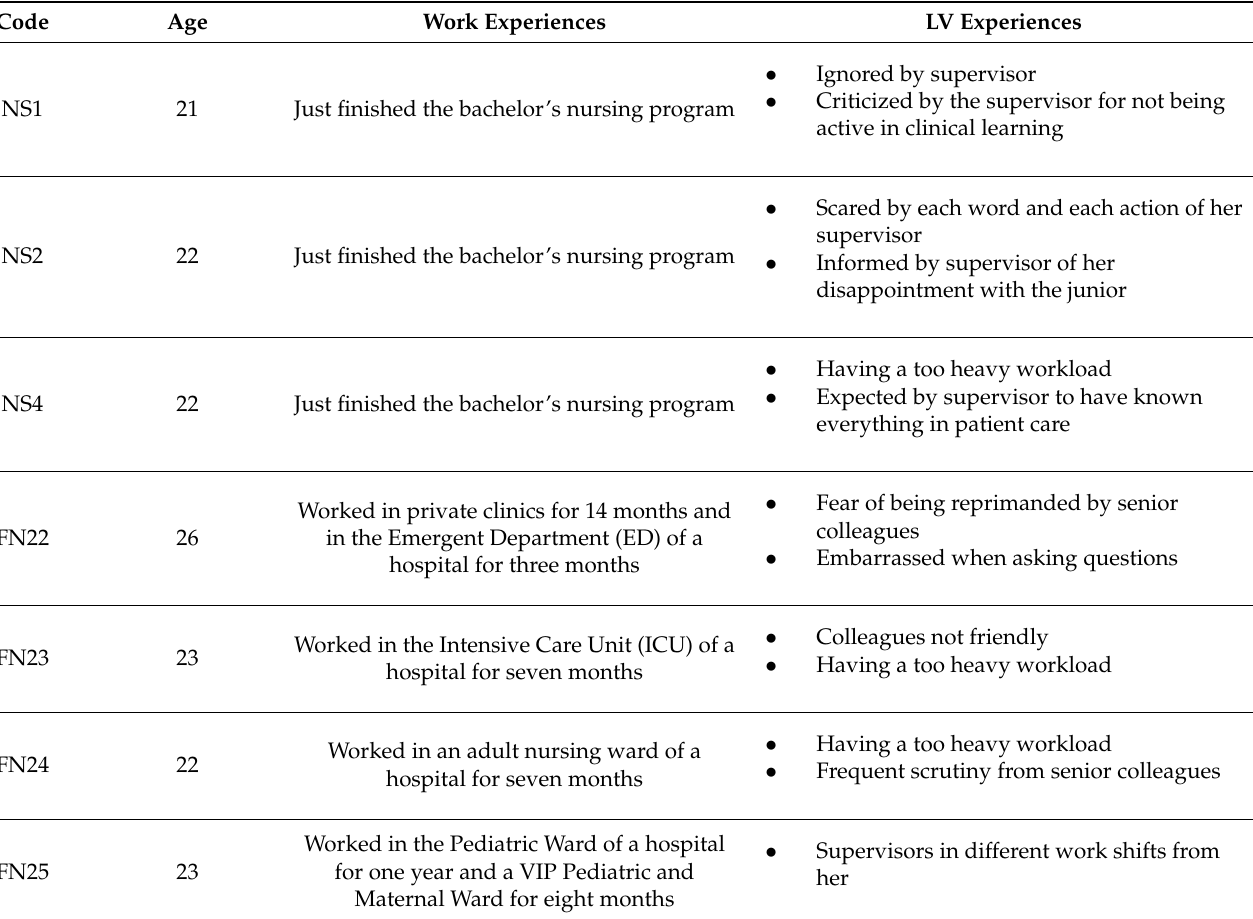
Table 1. A brief background of the 20 participants and their LV